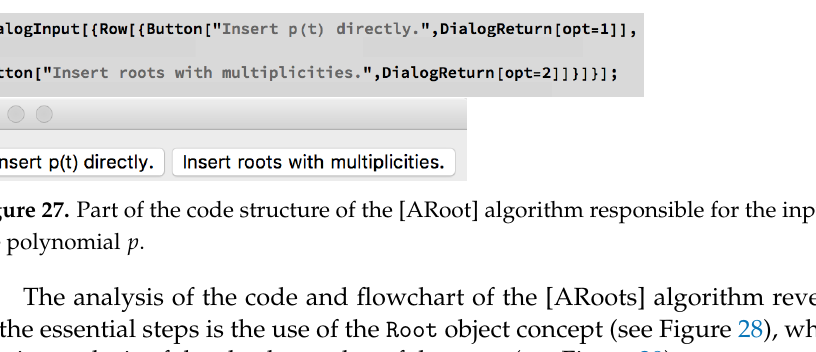
Figure 27. Part of the code structure of the [ARoot] algorithm responsible for the input options for the polynomial p .